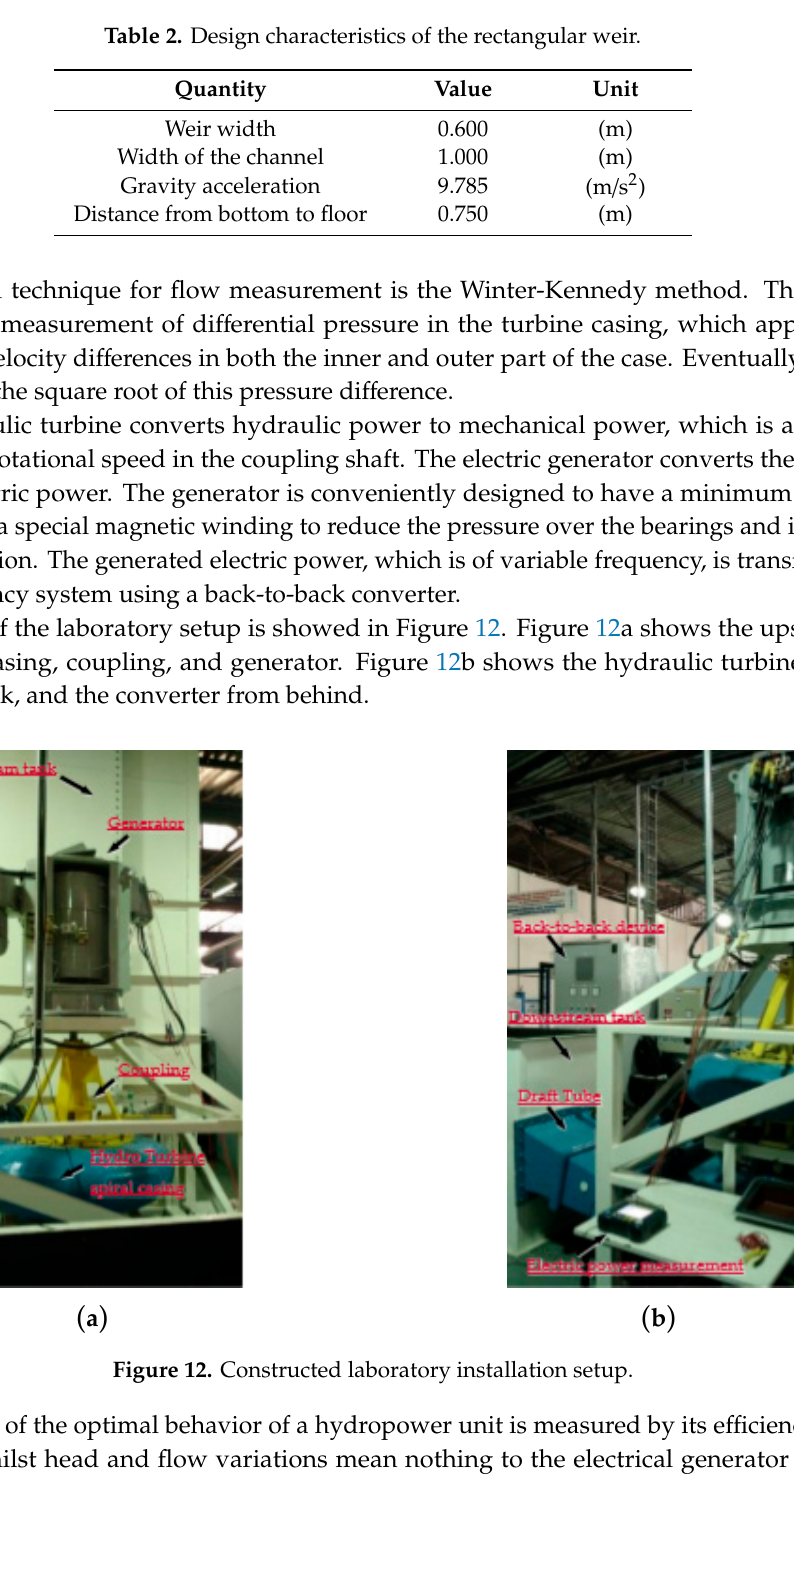
Table 3. Main characteristics of the sensors. Sensor